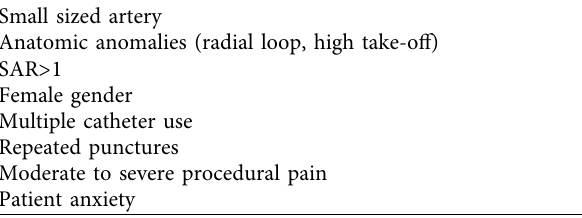
Table 6: Factors contributing to Radial spasm. Small sized artery Anatomic anomalies (radial loop, high take-off) SAR > 1 Female gender Multiple catheter use Repeated punctures Moderate to severe procedural pain Patient anxiety SAR: sheath outer diameter/artery